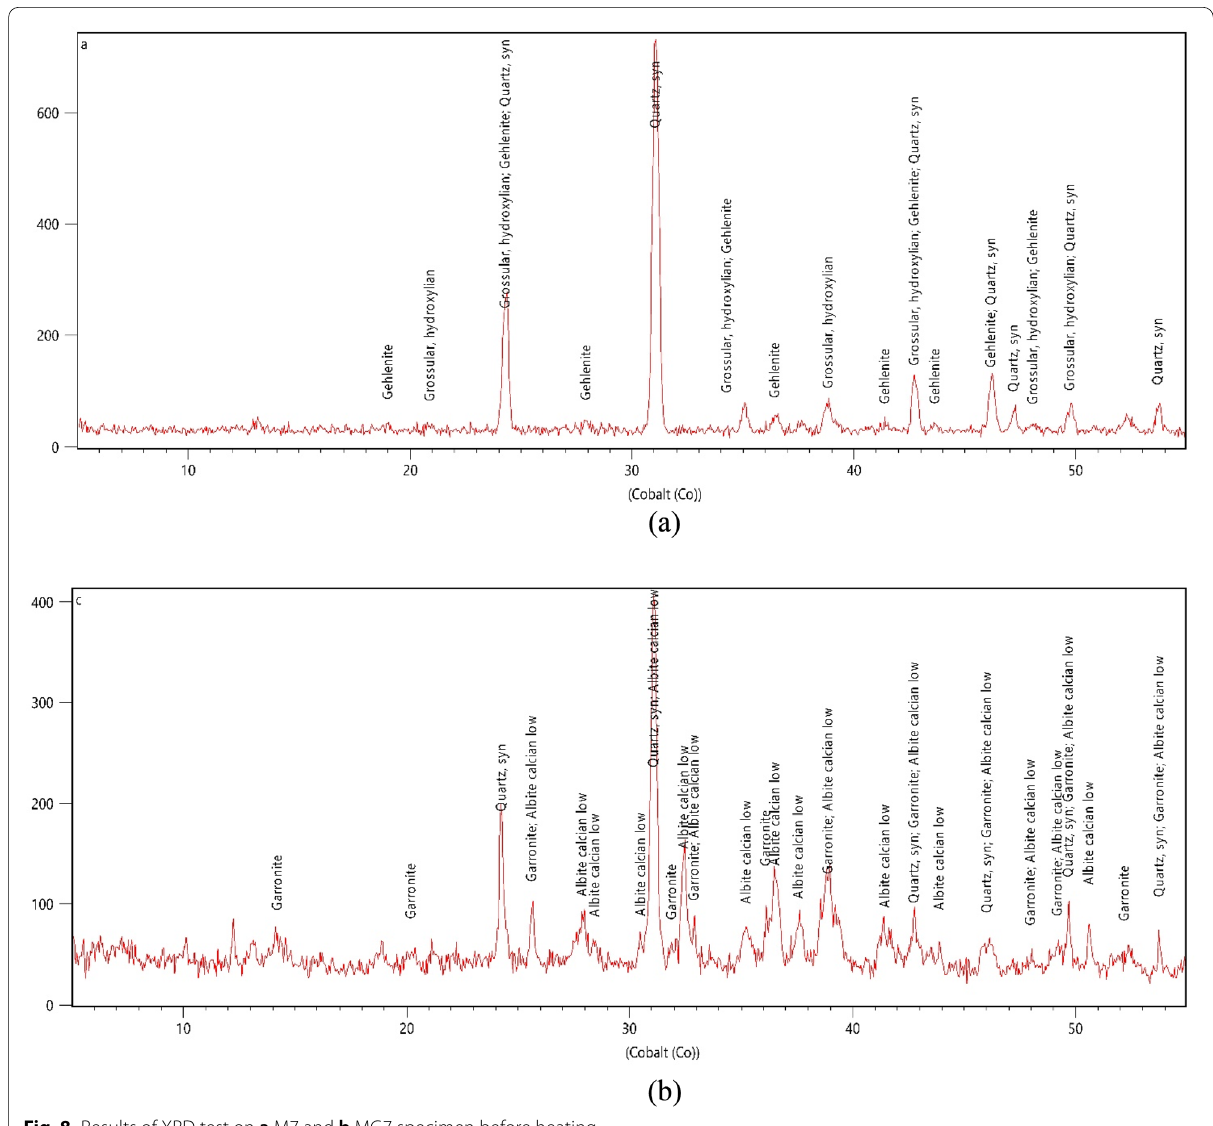
Fig. 8 Results of XRD test on a M7 and b MG7 specimen before